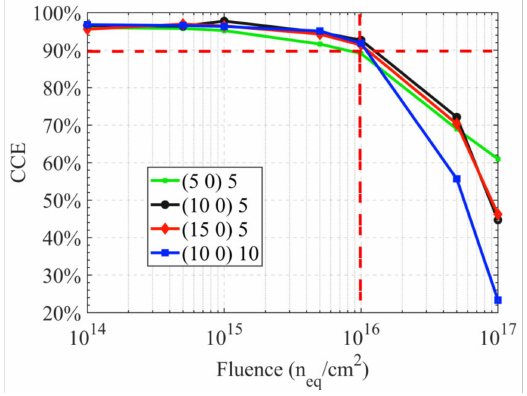
Figure 9. The charge collection efficiency (CCE) curves.